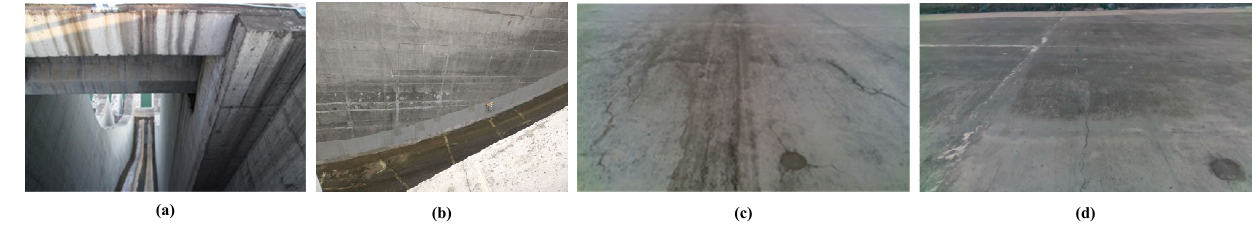
Figure 1. Dam spillway environment and surface image collection. ( a ) shows the top view of draft spillway in Three Gorges Dam. ( b ) shows the image collection status using climbing robot. ( c , d ) shows typical surface defect collection pictures by climbing